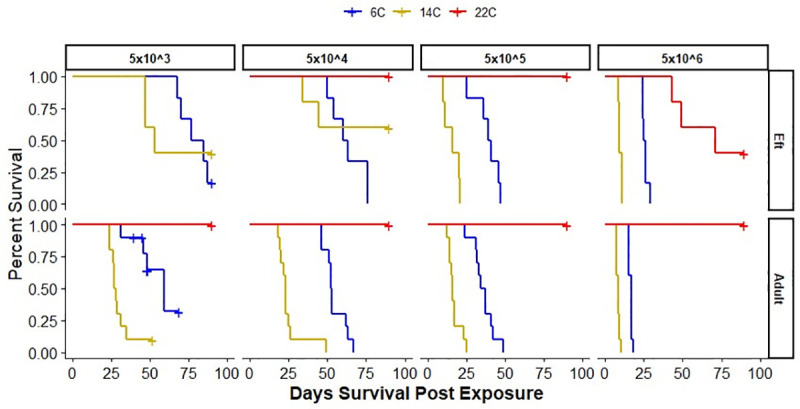
Survival curves representing the mortality rate of Notophthalmus viridescens held at 6, 14, and 22°C and exposed to four Batrachochytrium salamandrivorans doses (5x103-6 zoospores per 10 mL).The survival curves for adult and eft (juvenile) N. viridescens are shown in the lower and upper panels, respectively.